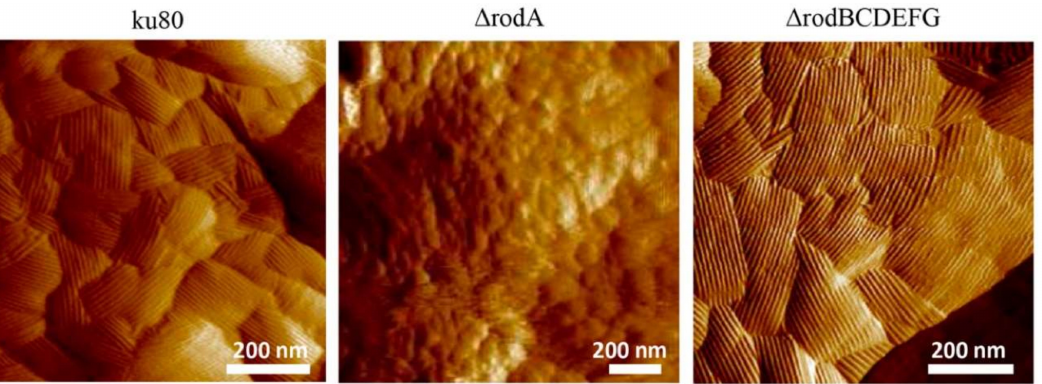
Figure 1. Structure of the conidial cell wall surface of A. fumigatus ku80, ∆ rodA , and ∆ rodBCDEFG . Atomic force microscopic images show the presence of rodlets on the surface of ku80 and ∆ rodBCDEFG and their absence on that of ∆ rodA , in which AfRodA is deleted (Reprinted with permission from [13]. 2017, Journal of Fungi